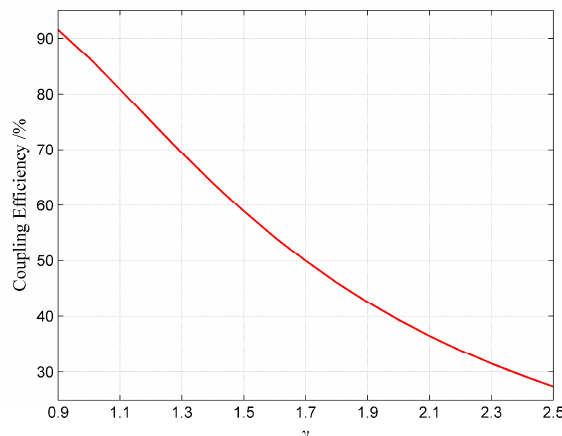
Figure 2. Theoretical coupling e ffi ciency η versus γ .